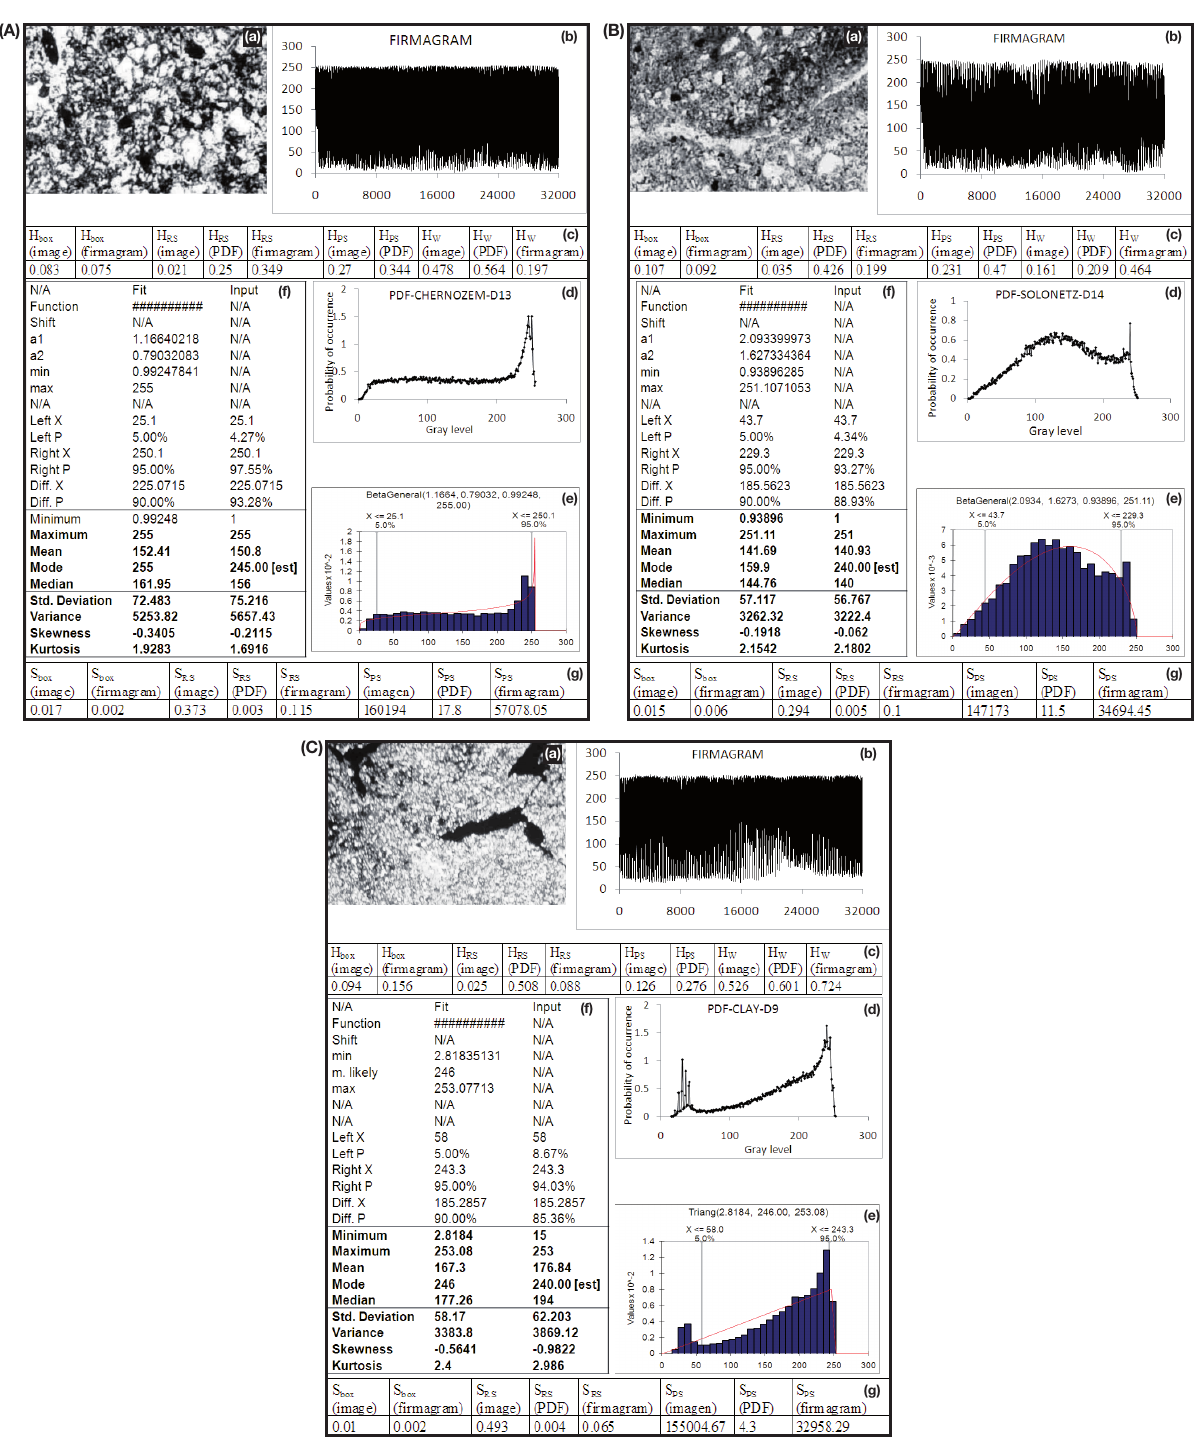
Fig. 4. Firmagrams (Ab, Bb, Cb) extracted from the micromorphological images of three studied soils: Chernozem (Aa) ; Solonetz (Ba) and Clay (Ca) , with contrasting structural patterns. The roughness values expressed in terms of Hurst ( H ) exponent (Ac, Bc, Cc) and their standard deviation (Ag, Bg, Cg) for the compared techniques. The distributions of gray intensities (Ad, Bd, Cd) are identified as visual singularities of the image: PDF (Ad, Bd, Cd) . These differences are detectable by eye when the graphs of data are fitted to the most probable theoretical distribution by software @Risk (Ae, Be, Ce) , and with the central moments calculated by the same software (Af, Bf,